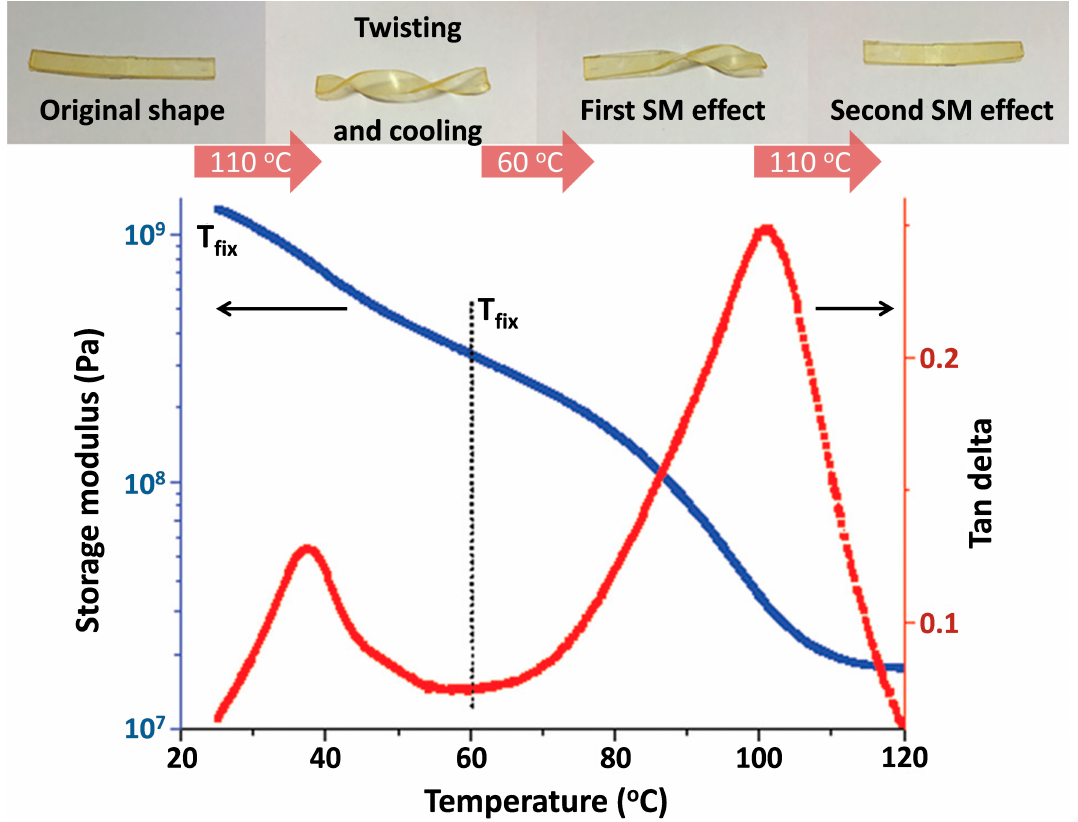
Figure 10. Images from an epoxy–silica-IL nanocomposite with dual SM effect showing its initial shape, deformation after heating up to 110 °C and subsequent cooling down, and first (60 °C) and second (110 °C) stages of SM effect (above). Nanocomposite’s storage modulus and loss factor tan δ temperature sweep, showing the transitions related to the dual SM effect [9] (Reproduced from Ref. [9] with permission from The Royal Society of Chemistry.).